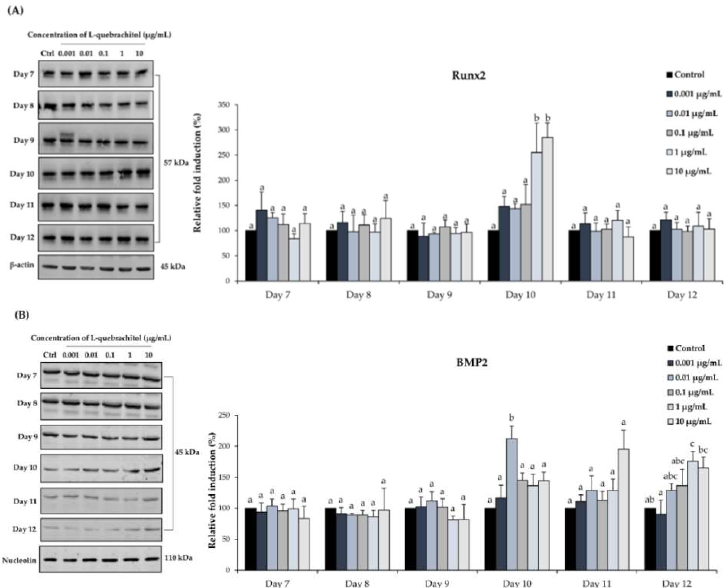
Figure 8. The effects of L -quebrachitol on the protein level expression of Runx2 ( A ) and bone morphogenic protein 2 (BMP-2) ( B ). MC3T3-E1 cells were treated with L -quebrachitol at various concentrations for 7, 8, 9, 10, 11, and 12 days. Levels of each protein (A,B, left-hand panels) were determined by Western blotting using cognate antibodies. Quantitation was performed